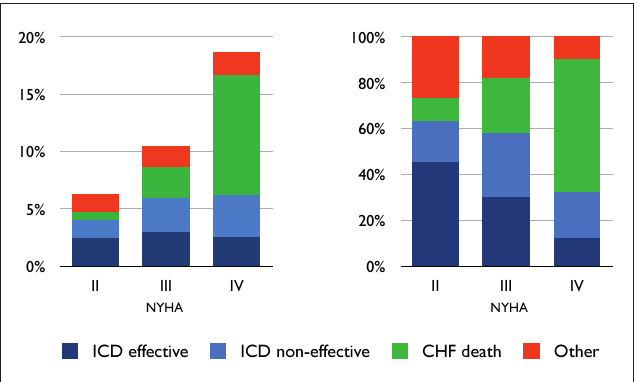
Figure 2 Theoretical absolute (left panel) and rela- tive (right panel) per- centage of effective ICD-therapy in heart failure depending on functional class. Mor- tality and frequency of mode of death in different functional classes derived from the MERIT-HF trial [21]. Effectiveness of ICD-therapy is esti- mated to be 75% in patients with func- tional class II and sudden cardiac death, 60% of SCD events in class III, and 40% of SCD events in class IV (es- timated and adapted eg from [22]). Blue bars indicate sudden cardiac death, green death from worsen- ing heart failure, red death from other causes. Relative fre- quency of sudden cardiac death de- clines substantially with progression of NYHA class, whereas heart failure events